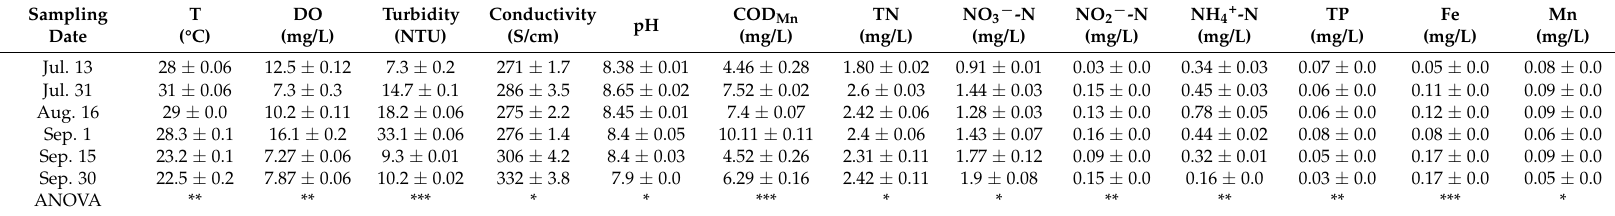
Table 2. Water quality parameters of Zhoucun drinking water reservoir during algal bloom outbreak and decline from July to September,